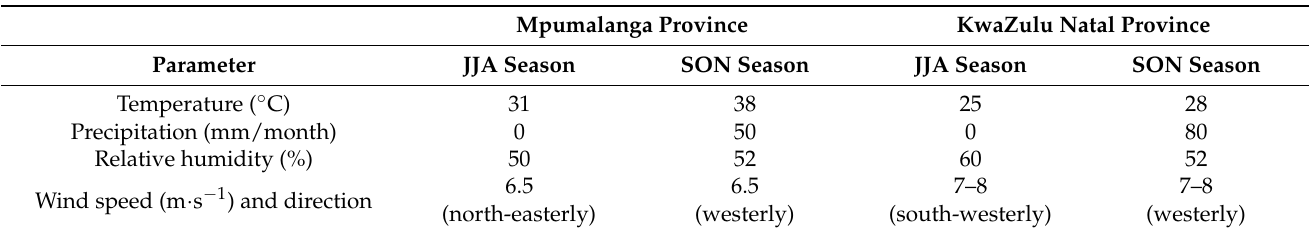
Table 1. Summary of the averaged climatic parameters over the Mpumalanga and KwaZulu Natal provinces.